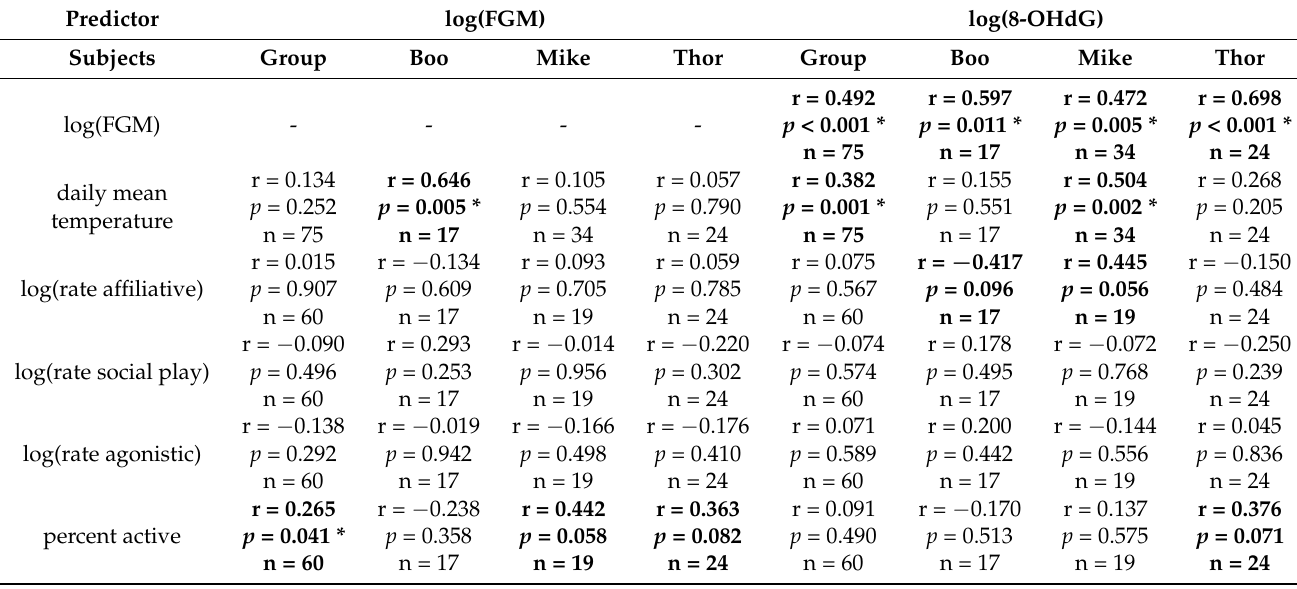
Figure 3. Scatterplots comparing log-transformed concentrations of fecal glucocorticoid metabolites (FGM) and fecal oxidized guanine (8-OHdG) in three male grizzly bears while they occupied a temporary, smaller habitat. Concentrations are expressed as ng/g dry feces. Table 3. Pearson correlation coefficients among physiological, environmental, and behavioral variables for three male grizzly bears. All variables were log-transformed to approximate normality except for the mean daily temperature and the percent of time spent active. * indicates p < 0.05, and statistical trends ( p < 0.1) are highlighted in